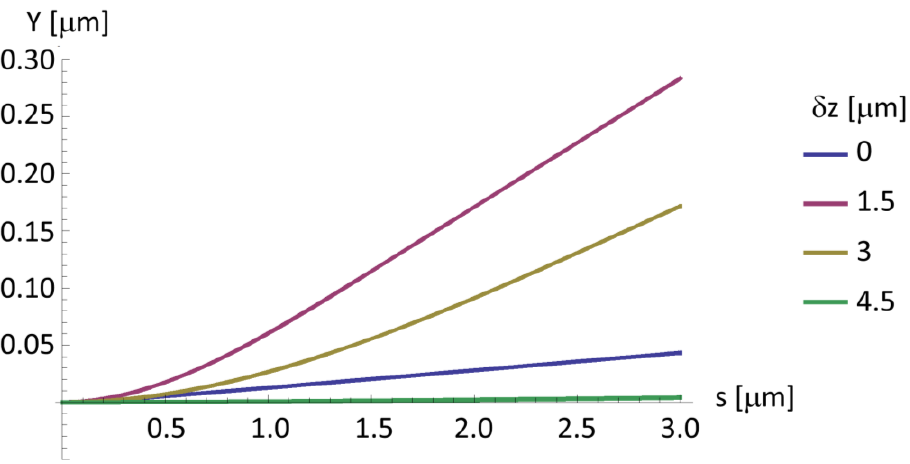
Figure 5. Example deformation of a primary cilium for a representative experiment, showing the effect of allowing the vertical displacement of the trap from the cilium base δz = 0, 1.5, 3, and 4.5 µm. The trap parameters: incident power P = 0.5 W, trapping lens numerical aperture NA = 0.95, and trap wavelength λ 0 = 1.064 µm. The trap center was displaced from the cilium axis by δy = 0.2 µm. The cilium length is 3.0 µm.